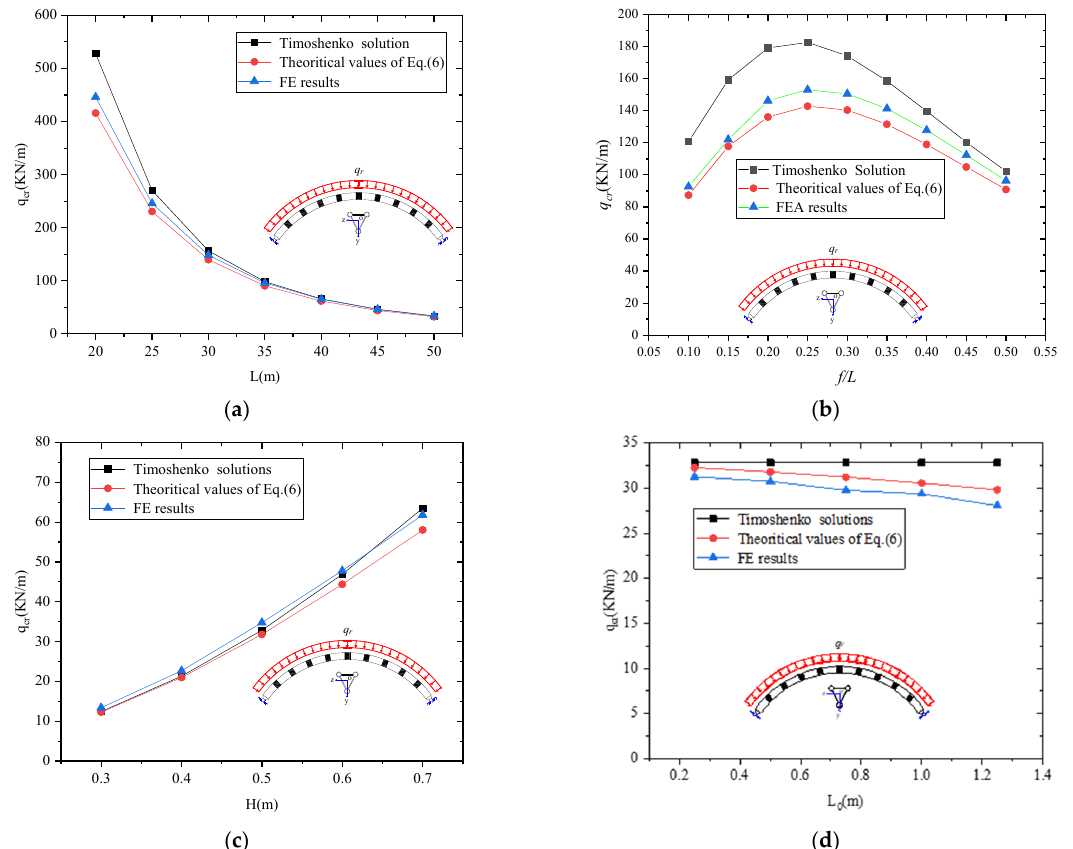
Figure 8. Comparison of FE results with the solutions of Equation (6): ( a ) changing span; ( b ) changing rise-to-span ratio; ( c ) changing section height; ( d ) changing clear spacing of connecting